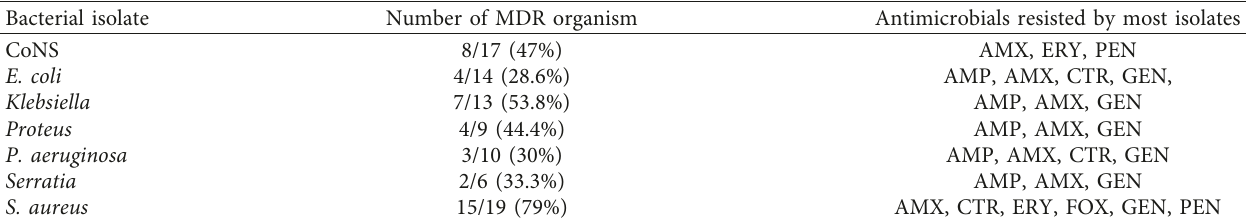
Klebsiella spp. Proteus spp. Serratia spp.